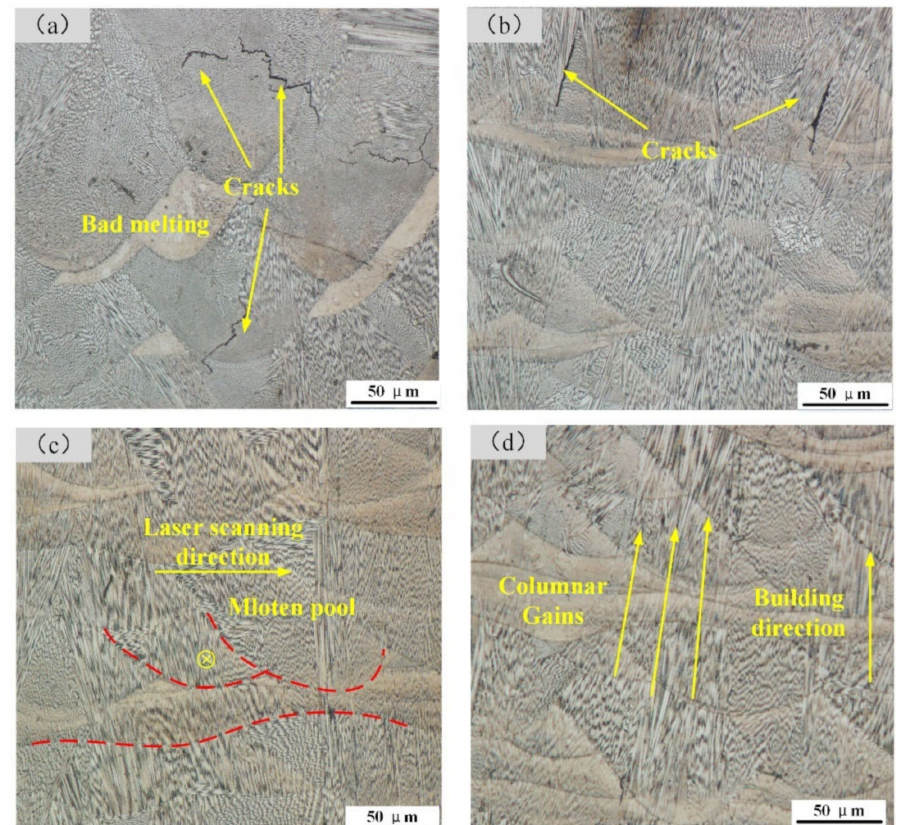
Figure 4. Optical micrographs of LPBF-manufactured K418 samples at various volumetric energy densities VED: ( a ) 37.5 J/mm 3 ; ( b ) 62.5 J/mm 3 ; ( c ) 81.6 J/mm 3 ; ( d ) 93.7 J/mm 3